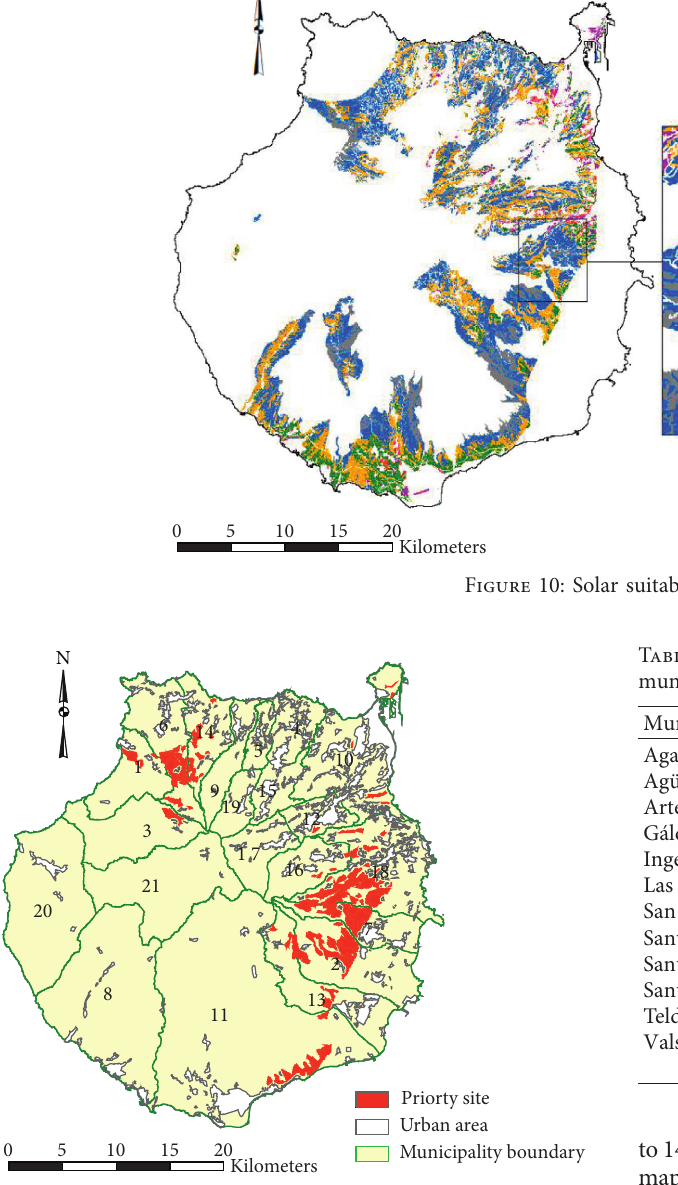
Figure 11: Priority sitemap (hybrid model).